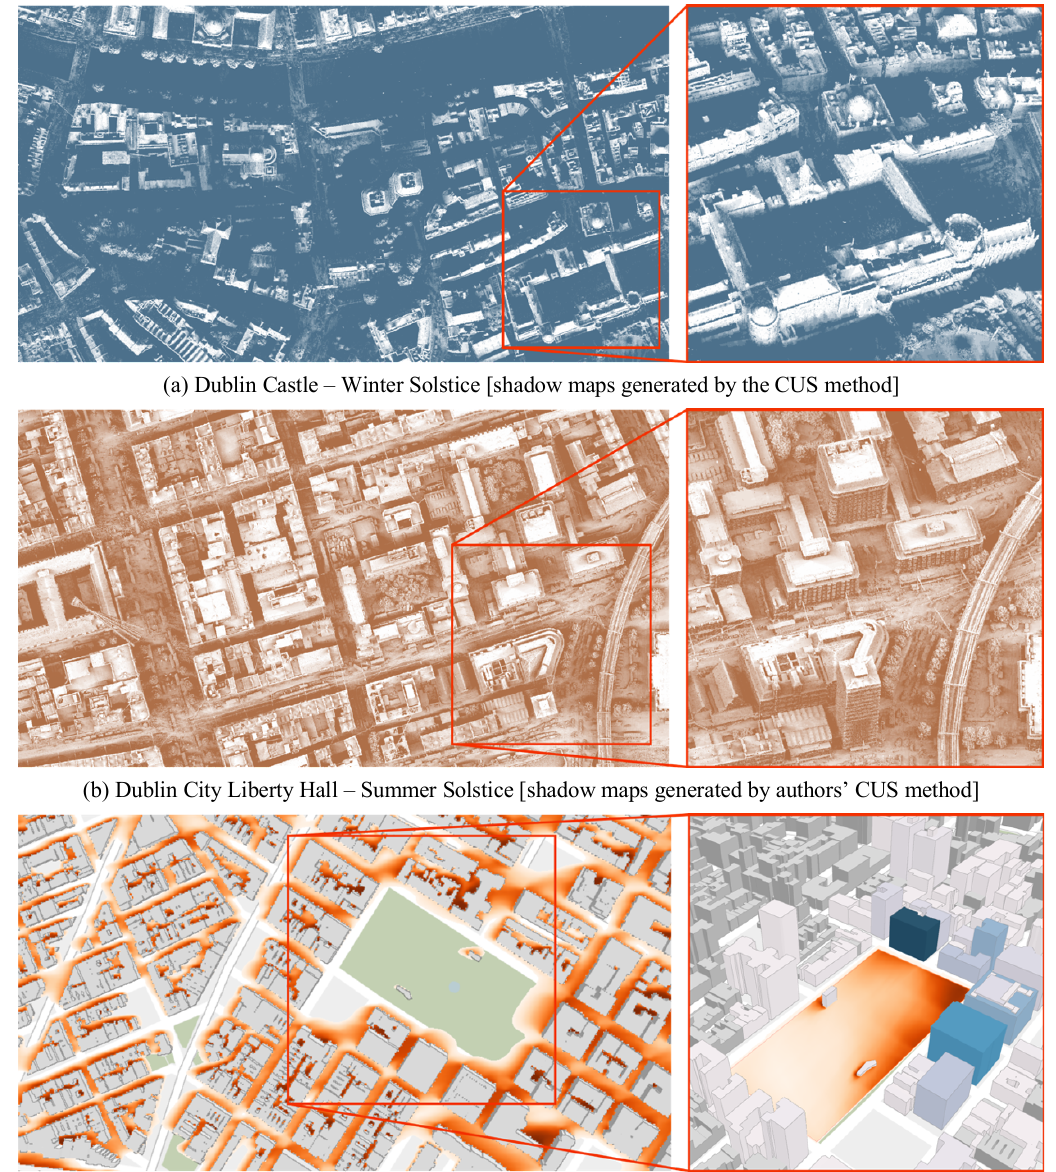
Figure 5. Shadow accrual